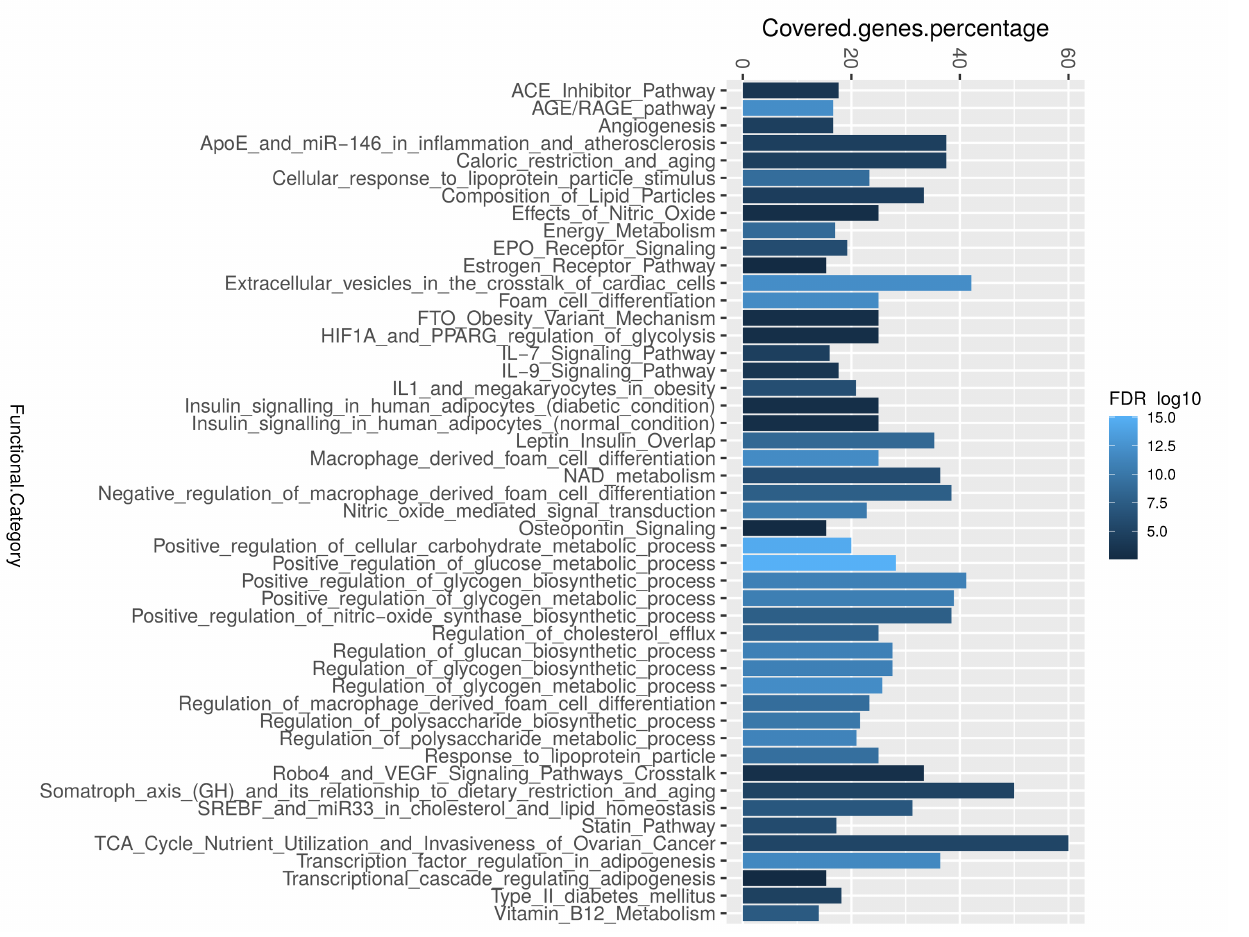
Figure 4. The enrichment analysis of the most common diabetes-associated genes in the literature. The most highly covered biological pathways, as determined by the ShinyGO software, where the R-ggplot was used to depict the percentage covered-genes